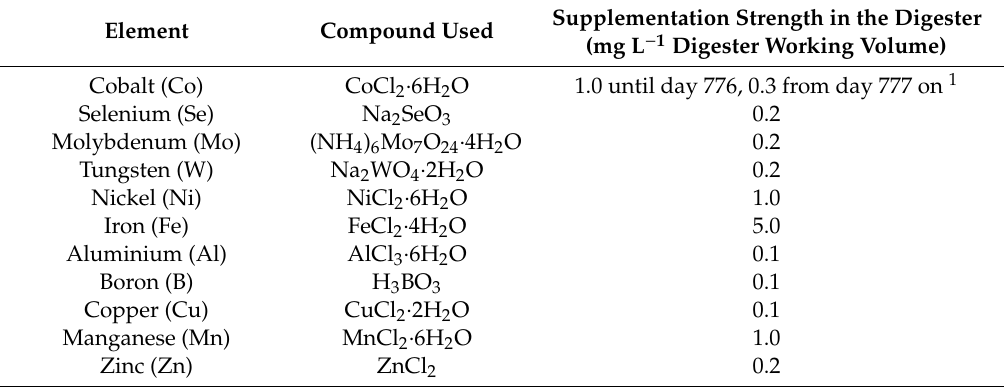
Table 2. Trace elements used in this